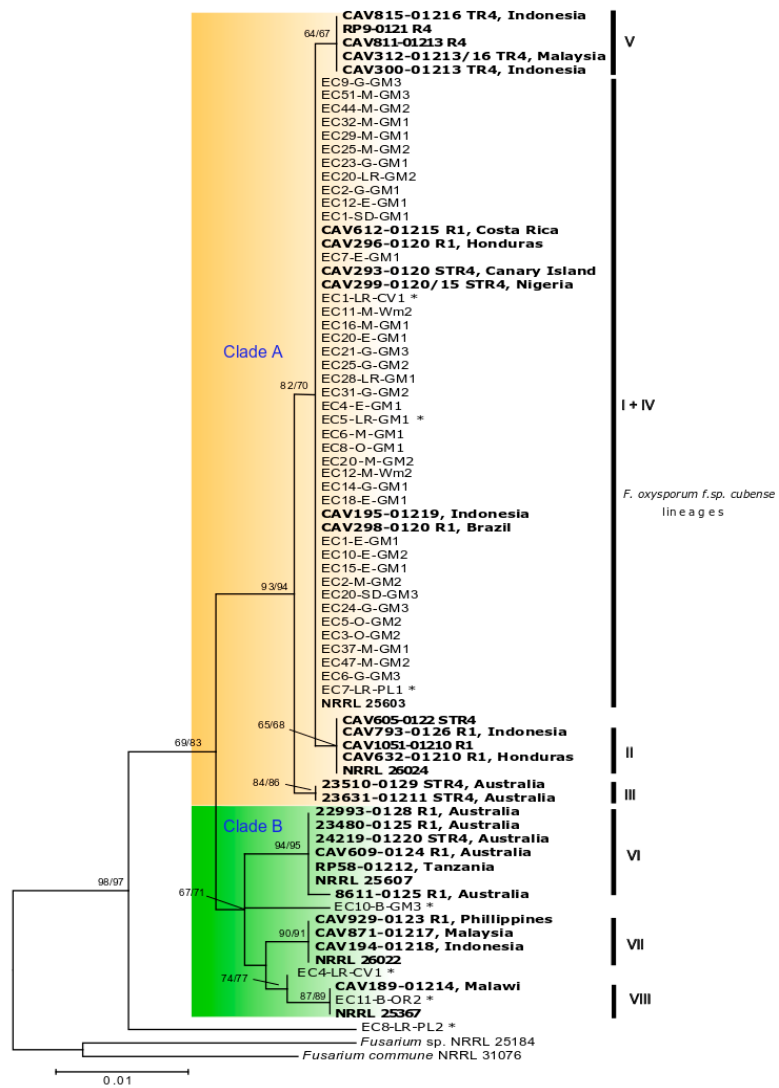
Figure 3. Maximum likelihood phylogenetic tree containing 44 selected F. oxysporum isolates associated to banana from Ecuador inferred from the TEF region sequence data. Clades are color-differentiated and included the various F. oxysporum f. sp. cubense strains (marked in bold) described by Fourie et al. [10] and indicated to the right side of the tree as lineages (I to VIII). Numbers above internodes represent the ML and MP bootstrap support. F. oxysporum from asymptomatic banana are marked with an *. The tree is rooted with Fusarium sp. NRRL 25184 and Fusarium commune NRRL 31076.